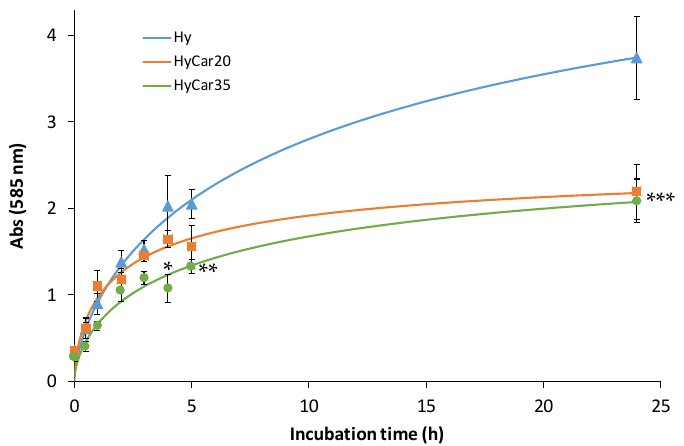
Figure 2. Enzymatic hydrolysis of HyCar20, HyCar35 and their parent polymer (Hy) (10 µM), catalyzed by HyAse (50 U/mL). (* p < 0.005 vs. Hy and HyCar20; ** p < 0.01 vs. Hy and HyCar20; *** p < 0.005 vs. Hy).